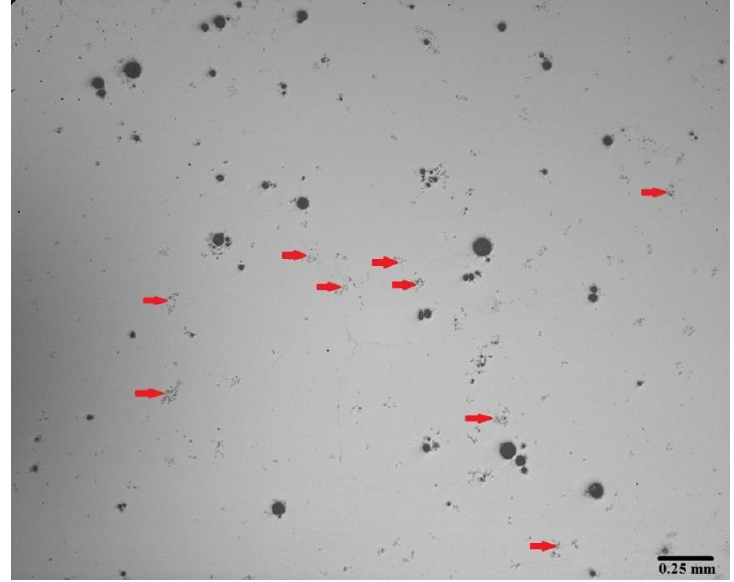
Figure 9. Micrograph related to the pre-existing clusters in the as-cast copper-free BMG.